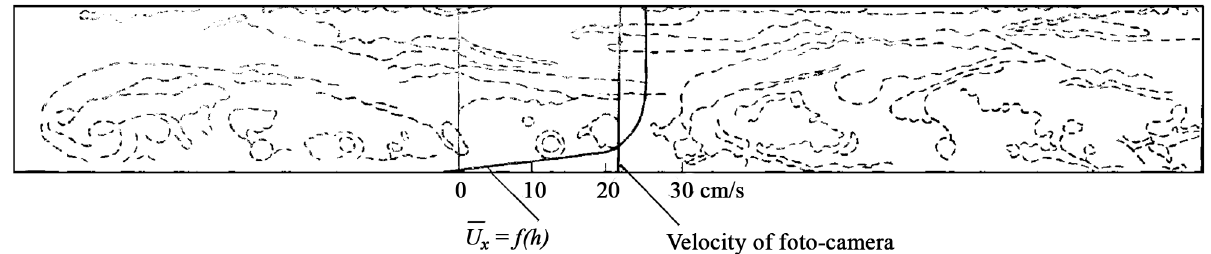
Fig. 2. Vector field of flow velocities according to the investigations of A. B. Klaven (1966)